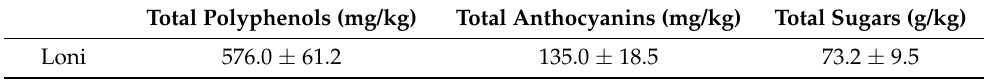
Table 1. Total polyphenols, anthocyanins, and sugars in the stoned fresh fruit of Lonicera caerulea L.